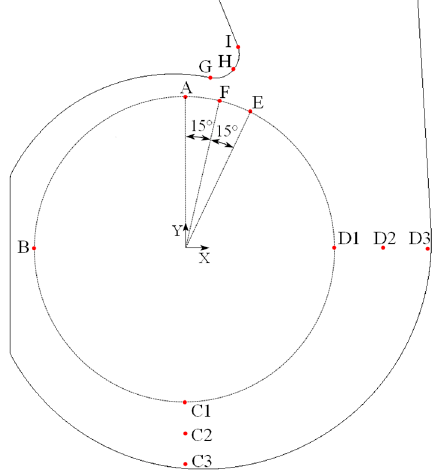
Figure 18. Positions for the static pressure monitors within the volute.